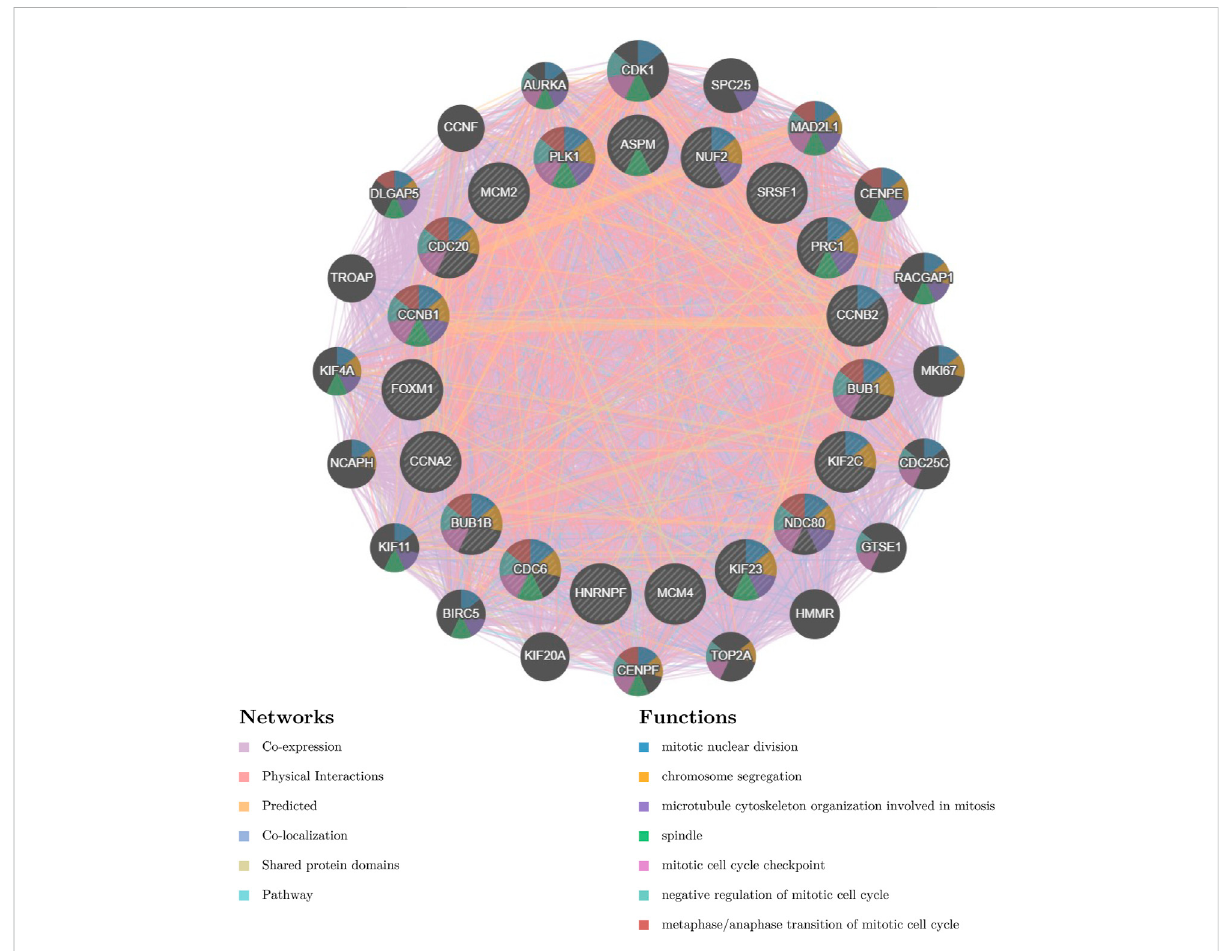
FIGURE 8 Protein – protein interaction network (GeneMANIA) of prognosis-related hub genes.